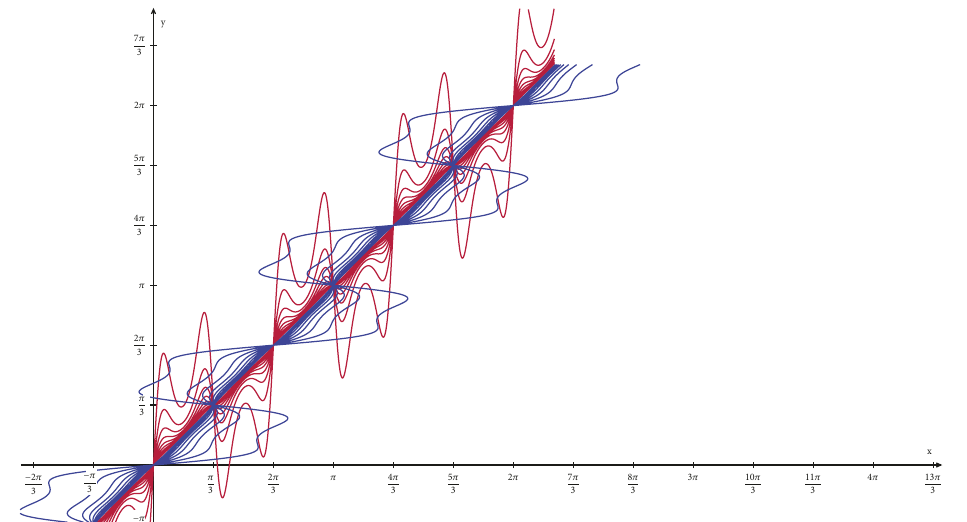
Figure 6: The figure shows a parametric plot of families of curves for system (9) for Ξ (𝑥) = 𝑥−𝜅 𝑥 𝑔 1 ( sin (3𝑥)) sin (3𝑥) , 𝜅 𝑥 = 0.66 , and different relatives weights 𝛼 = 0.1, 0.2, .. ., 0.9 (red lines), Ξ (𝑦) = 𝑦 − 𝜅 𝑦 𝑔 2 ( sin (3𝑦)) sin (3𝑦) , 𝜅 𝑦 = 0.4 and different relative weights 𝛿 = 0.1,0.2, .. ., 0.9 (blue lines). The intersections correspond to different fixed points of different pairs of equations. Notice that only those fixed points of the form (𝑝, 𝑝) are common to all equations in system (7). Other fixed points depend on parameters’ values.